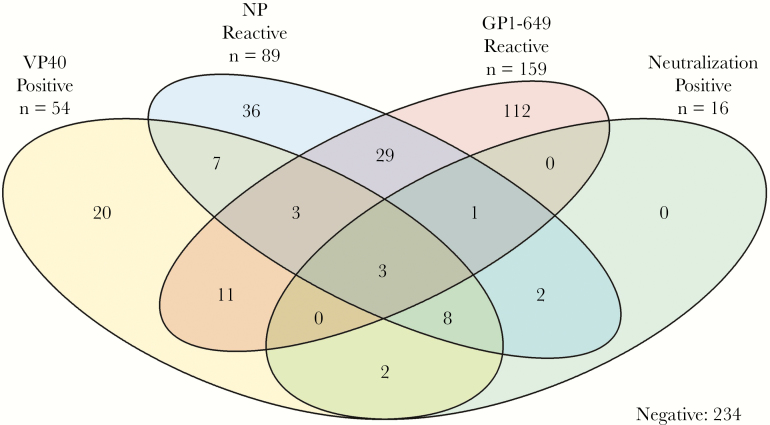
Venn diagram of overlapping immunoreactivity assay measures in healthcare workers who participated in the Boende outbreak, Democratic Republic of the Congo, 2014. Abbreviations: GP, glycoprotein; NP, nucleoprotein; VP40, Ebola virus matrix protein.